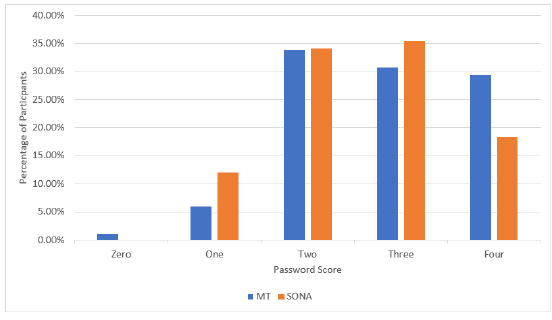
Figure 7. Password Scores in MTurk vs